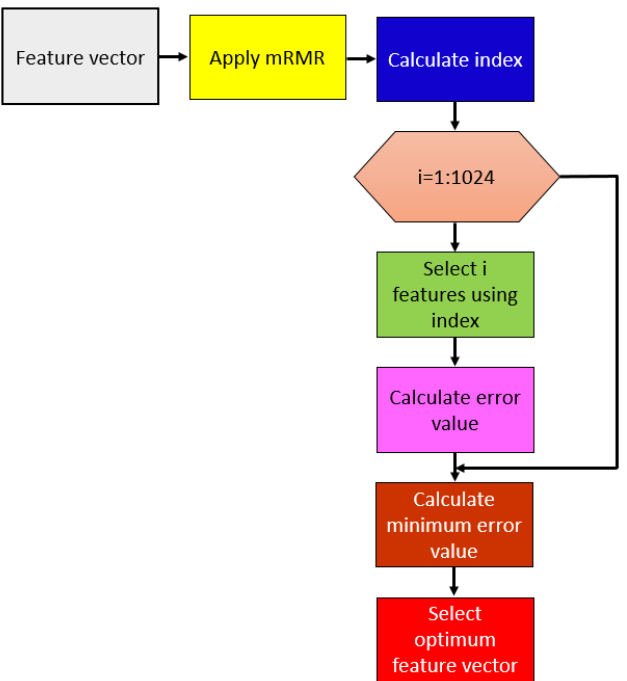
Figure 4. Steps involved in the selection of an optimal number of features using the ImRMR